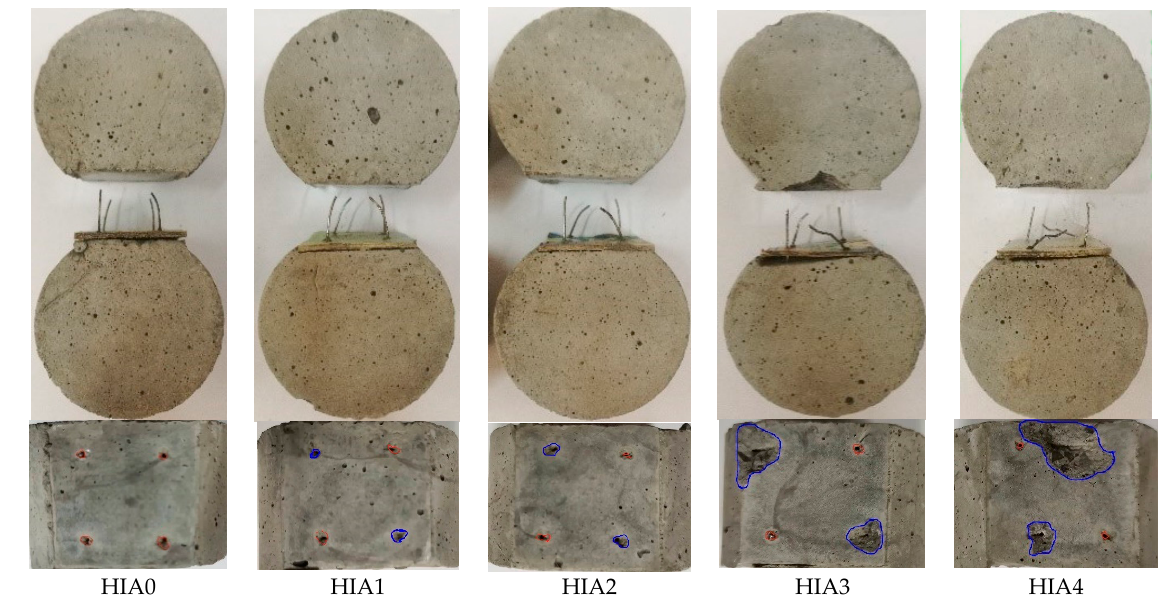
Figure 4. Typical failure mode of Series HIA. Figure 5 presents the typical failure mode of Series NA. All steel fibers of NA0, NA1, NA2 and NA3 were pullout with straightened hook-end, while the mortars of NA4 peeled off accompanied with slightly straightened hook-end of steel fibers. The tensile strength of the mortar near the fiber end is not enough to resist the stress transmitted by the fiber to the matrix. This indicates a rational spacing among steel fibers is necessary to ensure a sufficient surrounding mortar which can provides anchorage shear resistance of the inter- face between steel fiber and mortar.